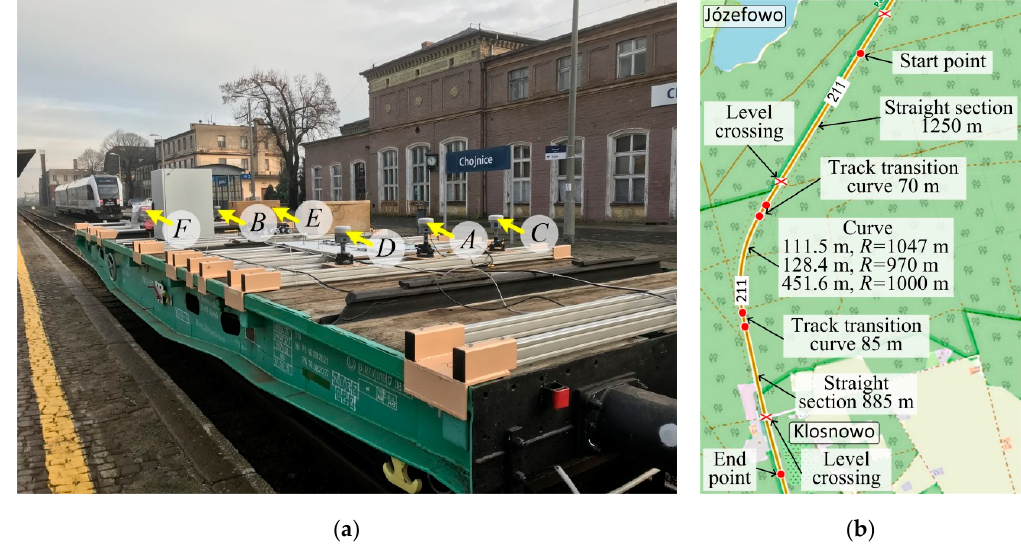
Figure 3. Test stand: ( a ) view of mobile measuring platform with receivers A , B , ... , F installed on 401Z flatcar; ( b ) general map of part of railway line No. 211 between Chojnice and Brusy stations (https: // www.openrailwaymap.org).